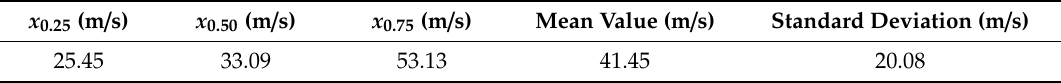
Table A2. Some basic statistical parameters (quartiles, mean, and SD) of the EWS data in Table 1. x 0.25 (m /